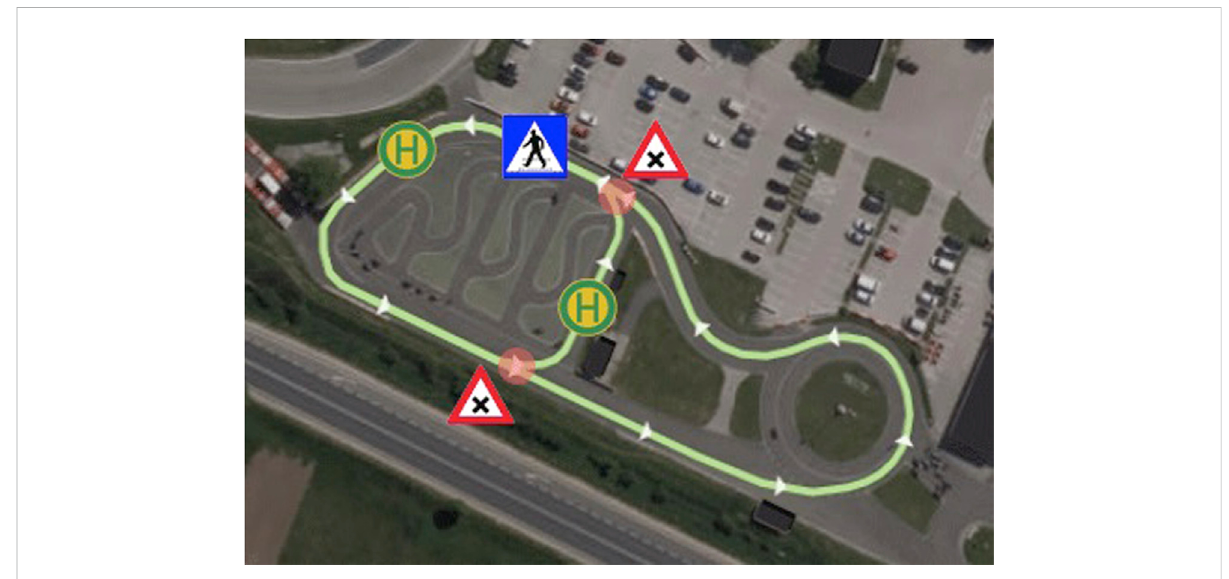
FIGURE 8 Top-down view of the test track showing the pedestrian crossing, vehicle intersections, and bus